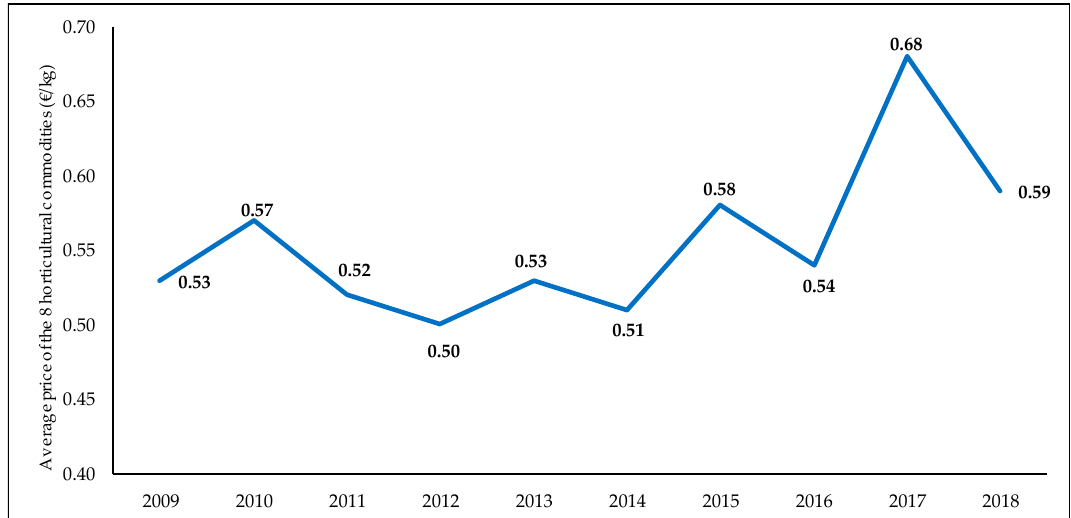
Figure 1. Evolution of the average price of the eight horticultural commodities grown under plastic greenhouses (tomato, pepper, cucumber, courgette, aubergine, green bean, melon, and watermelon) produced in the province of Almería (Spain) from 2009 to 2018, in €·kg − 1 [17]. Source: Own elaboration made with data provided by the Provincial Delegation of the Regional Department of Agriculture of the Andalusian Regional Government in Almería (Spain) (2009 to 2018) [17]. The data of Figure 1 are obtained from Tables 1 and 2, calculating the weighted mean with the areas of each crop. Table 2. Average price of the eight horticultural commodities grown under plastic greenhouses (watermelon, melon, courgette, cucumber, aubergine, tomato, pepper, and green bean) produced in the province of Almería (Spain) from 2009 to 2018, in €·kg − 1 [17]. Crop